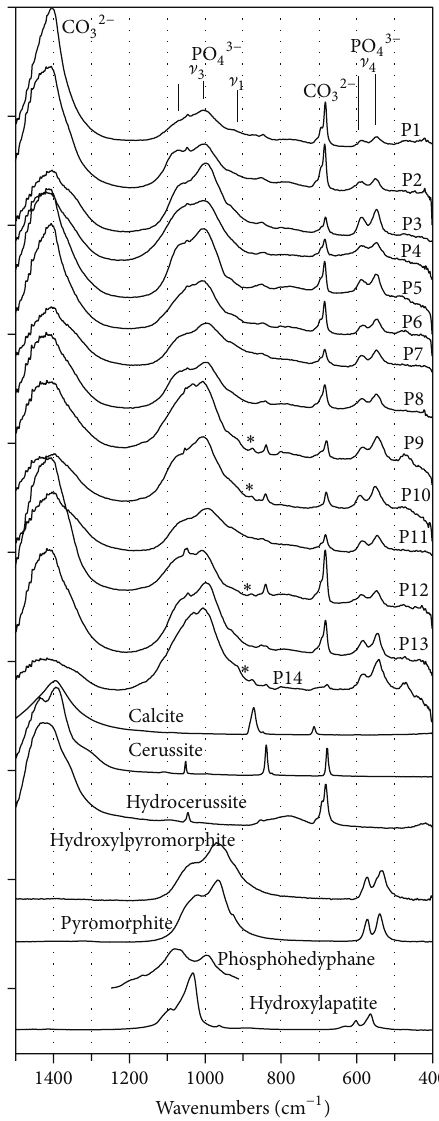
Figure 4: Lead mineral scale. Comparison of the FTIR spectra of lead pipes P1–P14 with spectra of carbonate and phosphate